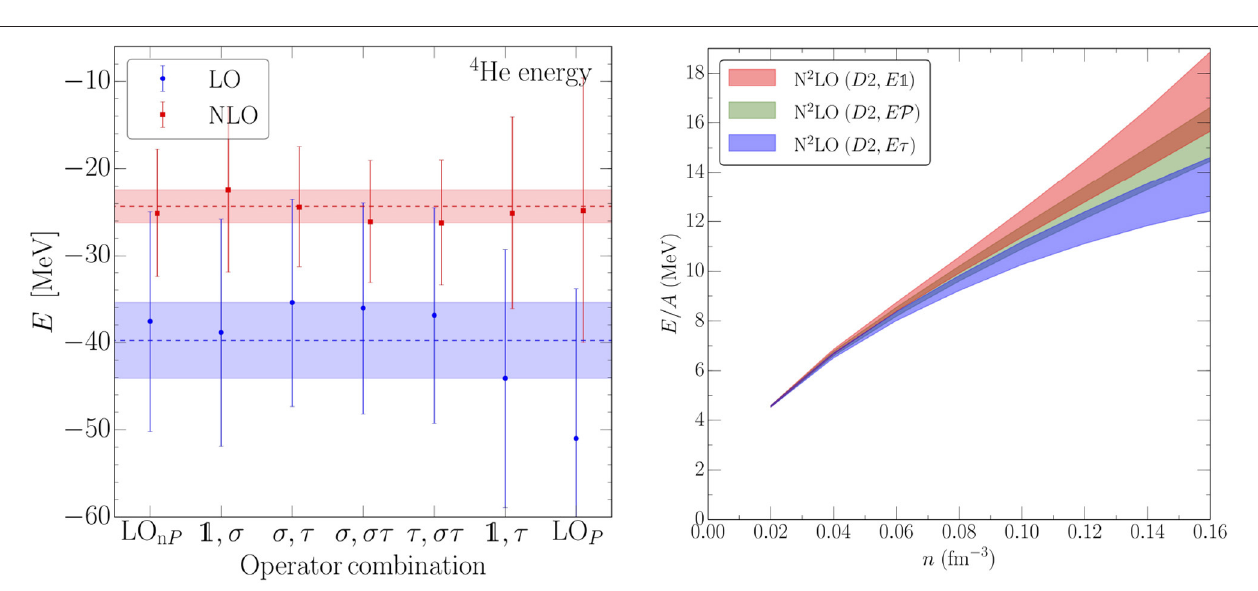
antisymmetric fermionic states (see e.g., Equation